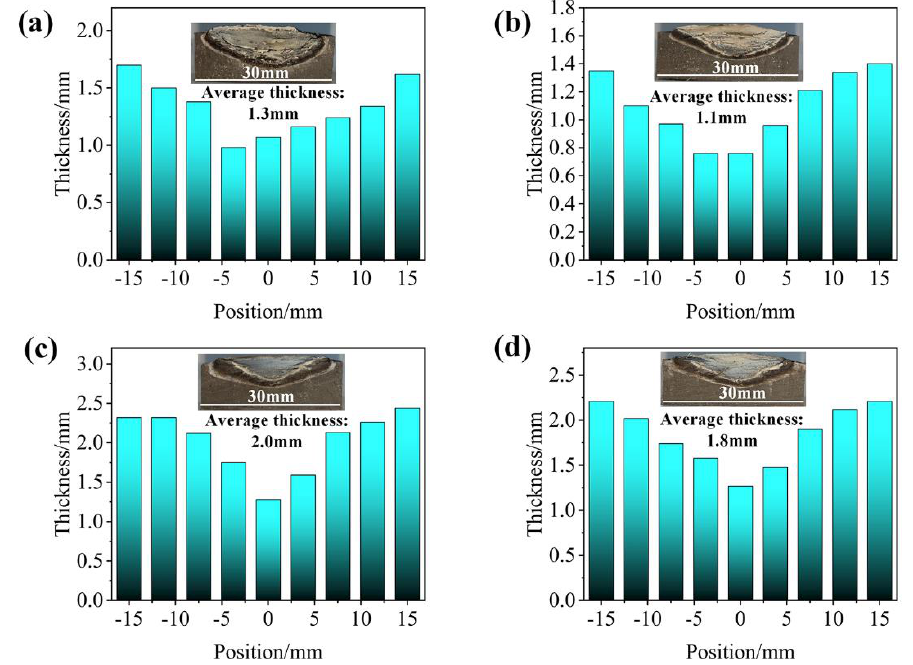
Figure 12. Thickness distribution of the ceramic layer: ( a ) SF-0.5; ( b ) SF-1; ( c ) SF-3; ( d ) SF-6.